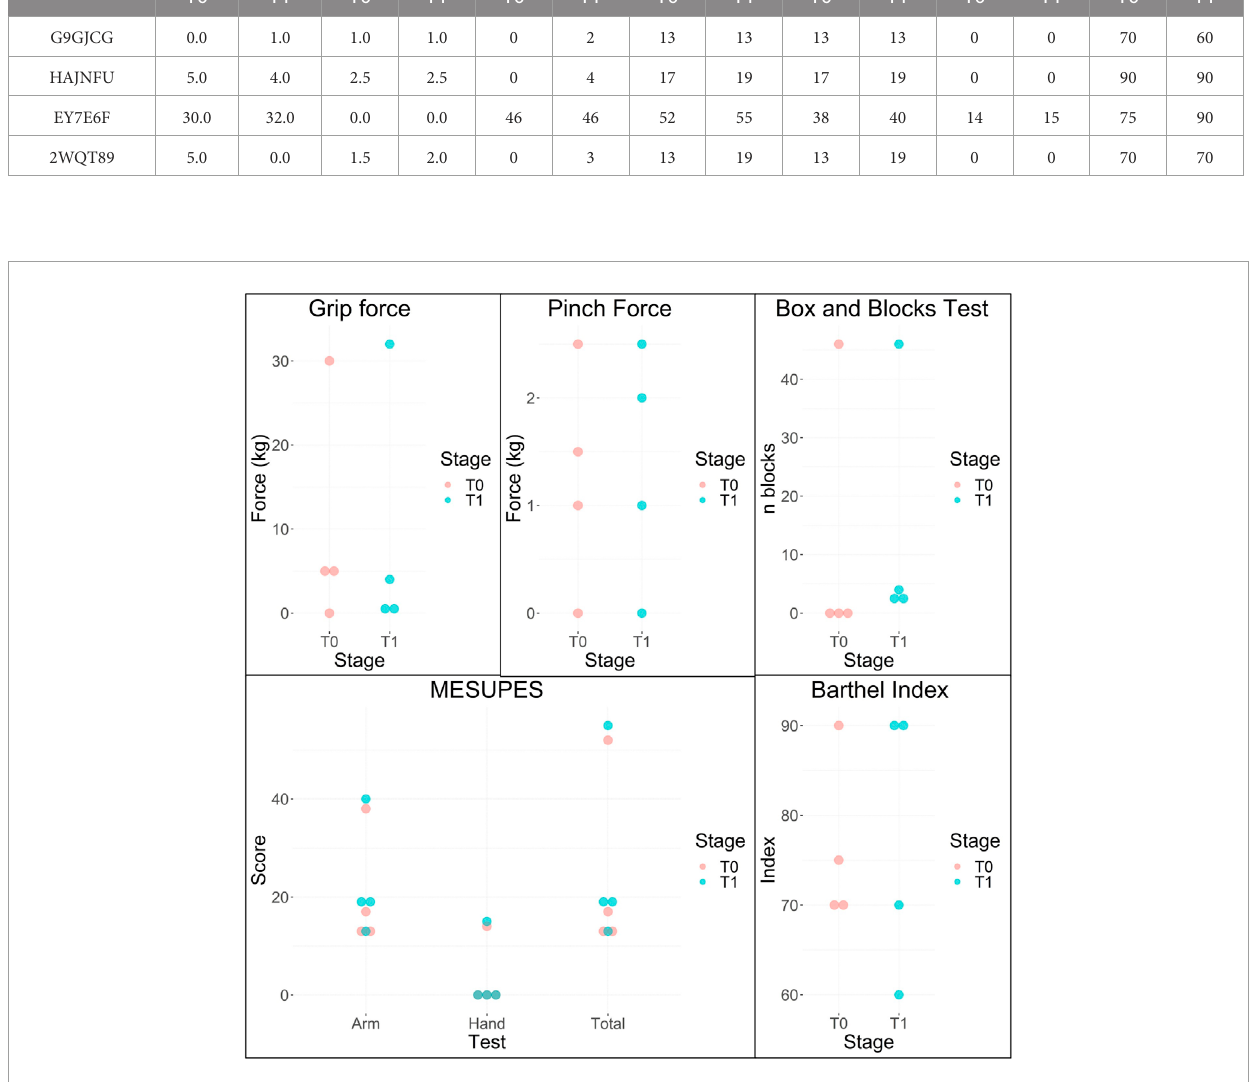
FIGURE 6 Baseline (T0) and post intervention (T1) results of grip dynamometry, pinch dynamometry, BBT, MESUPES and